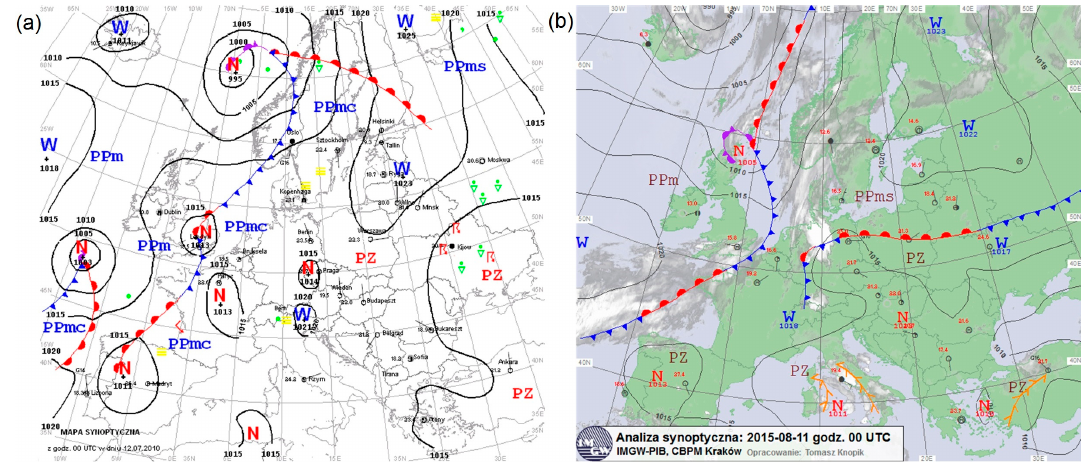
Figure 11. Weather situation on 12 July 2010 ( a ) and 11 August 2015 ( b ). Source: Meteorology and Water Management–National Research Institute.